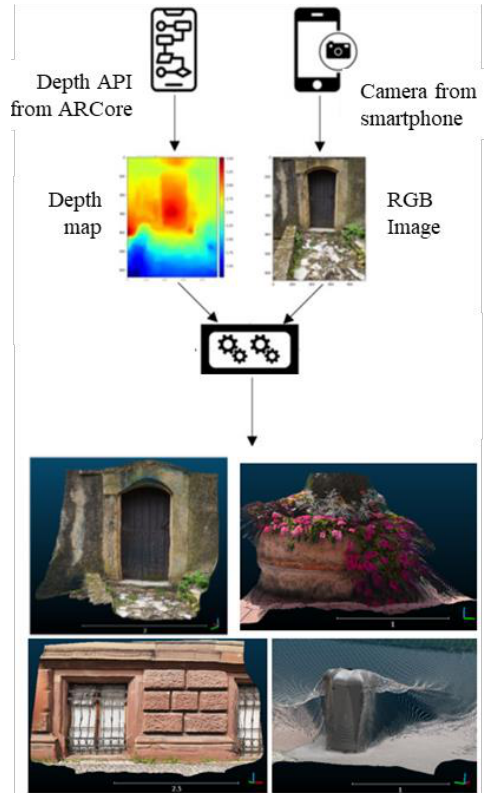
Figure 6. Example of reconstructions provided by our solution